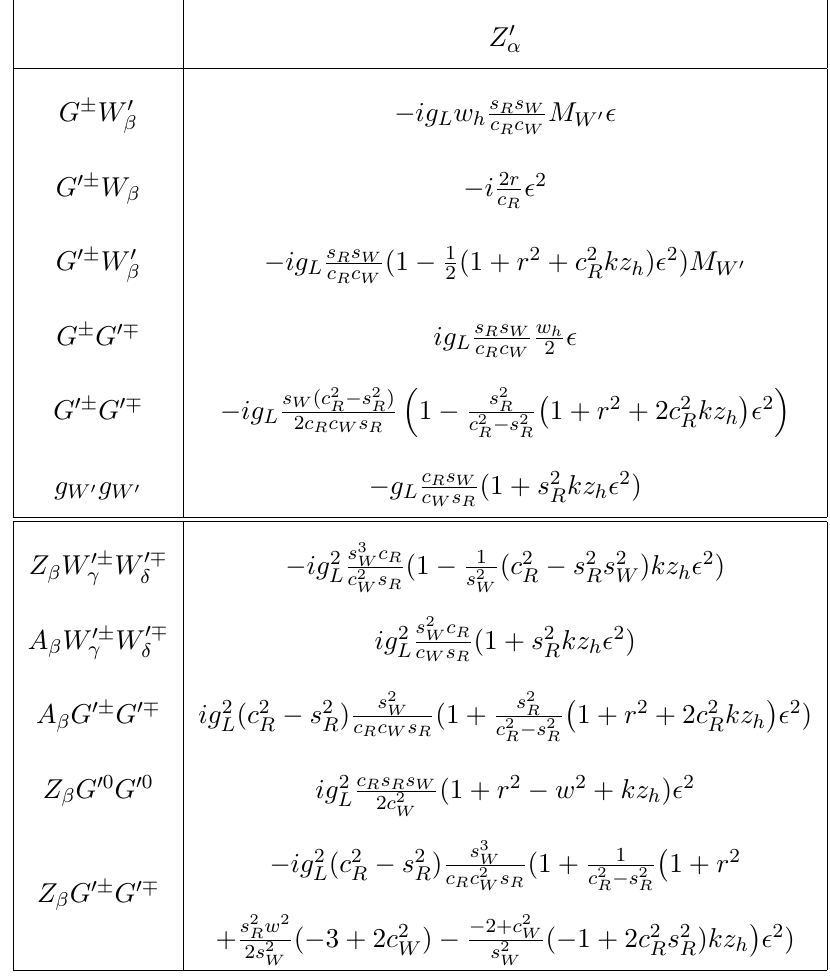
Table 17 . Triple and quadruple gauge couplings involving a Z 0 boson and at least one unphysical Goldstone boson. For the factor multiplying these couplings see table 16.